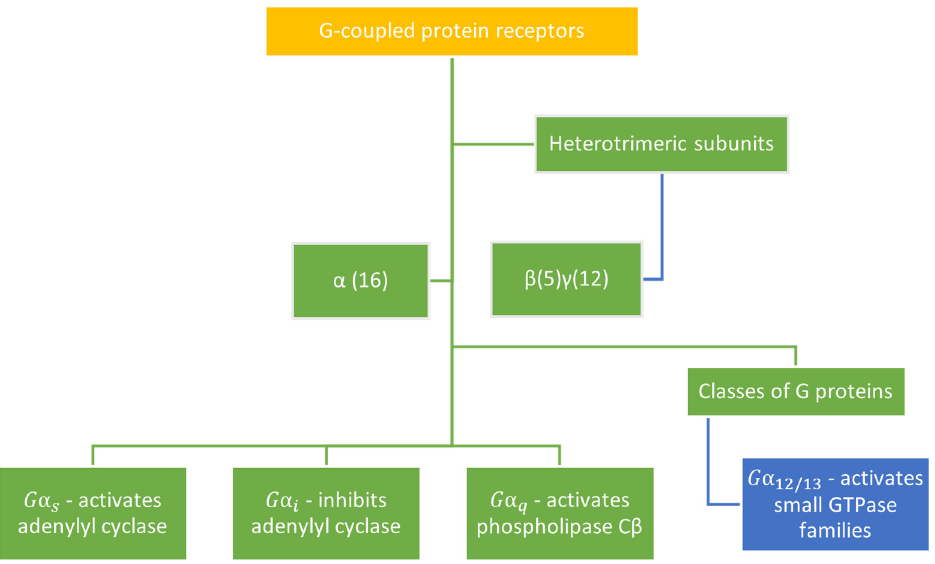
Figure 7. The four families of G-proteins interact differently with effector proteins to initiate signaling